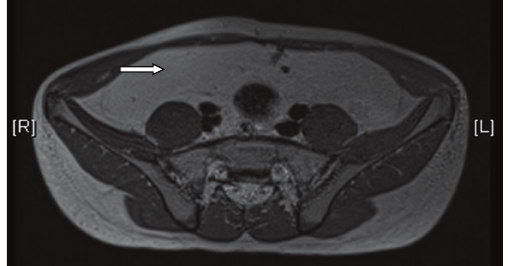
Figure 2: MRI pelvis: lipomatous tissue in the pelvis.